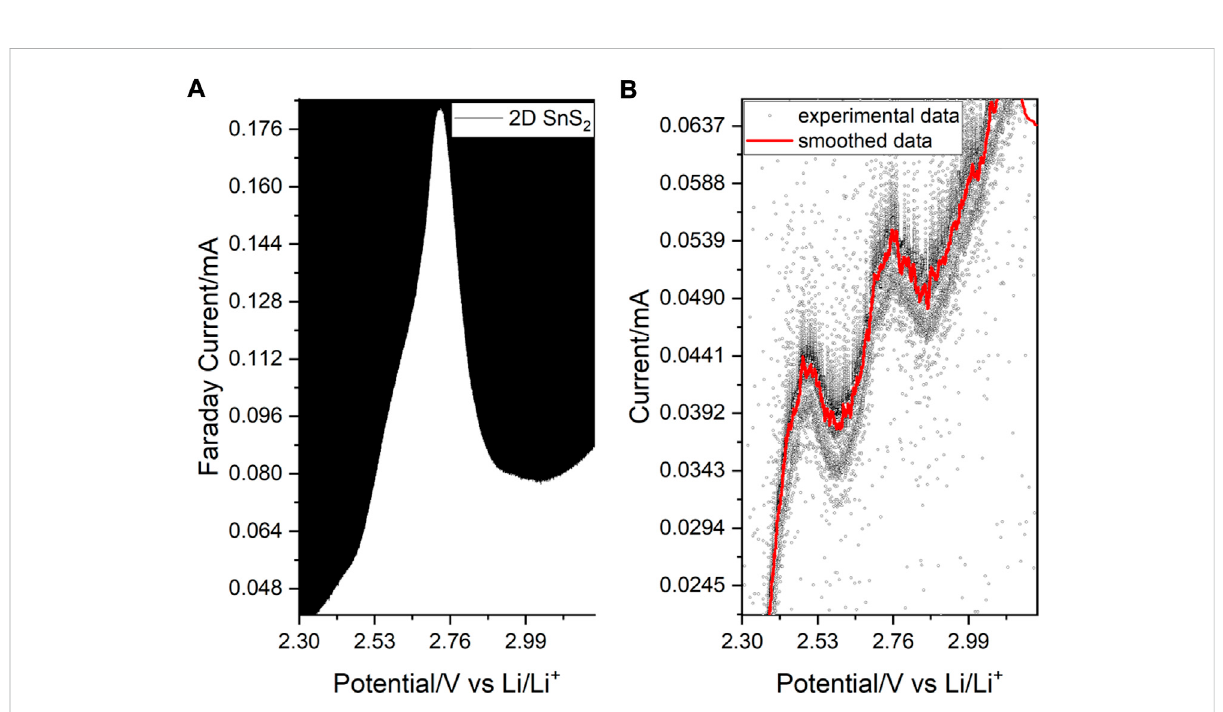
FIGURE 4 (A) Anodic DPV spectrum showing a major peak with a hidden contribution. (B) SPEIS-deconvoluted current/potential relationship involving two peaks grasped during 1399 potential steps (37 frequency points per step), which are seen in A as a shoulder preceding the main